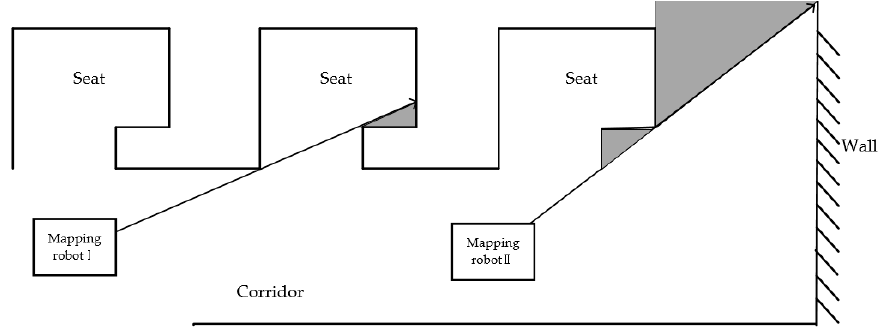
Figure 9. Theoretical path diagram after modifying the algorithm.